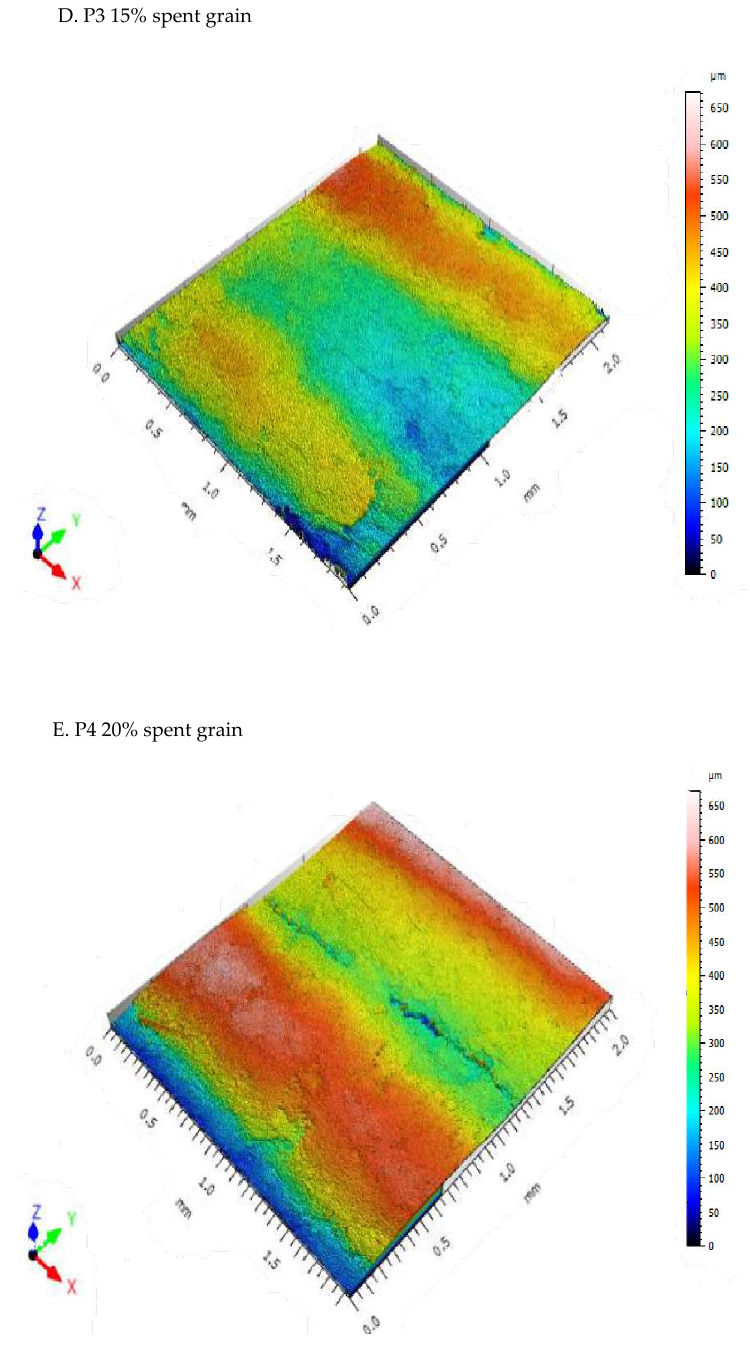
Figure 5. Dry pasta microstructure: ( A) Control sample, ( B) P1 with 5% spent grain addition, ( C) P2 with 10% spent grain addition, ( D ) P3 with 15% spent grain addition, ( E ) P4 with 20% spent grain addition.